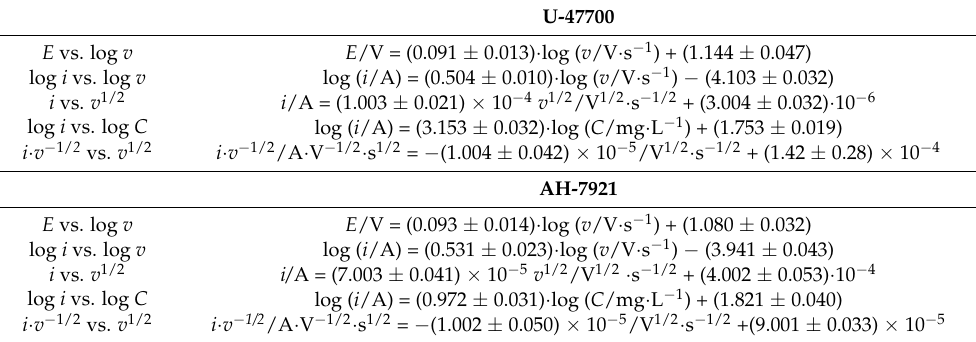
Table 3. Curves used for the determination of the electrochemical parameters exposed in the text. C = concentration ( µ g · mL − 1 ); v = scan speed (V · s − 1 ); i = current intensity (A). The standard deviation is reported after the numerical